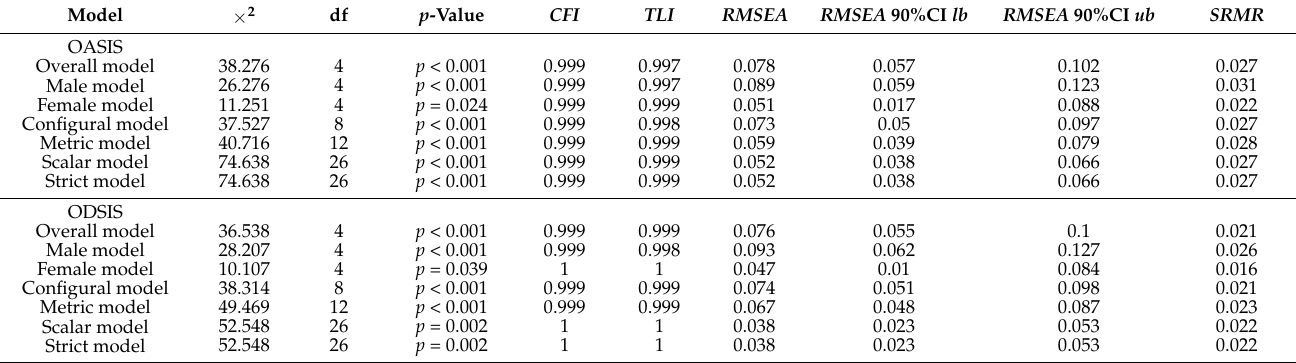
Table 2. OASIS and ODSIS measurement invariance models (Sample 1, n =